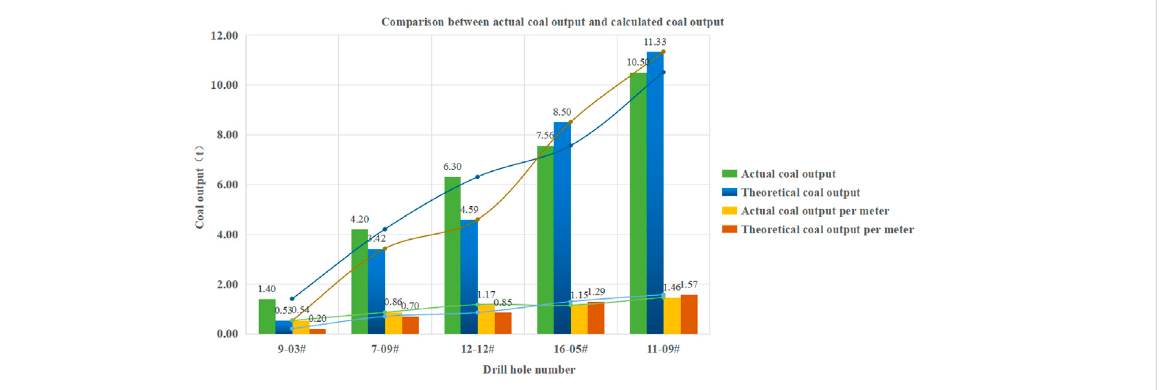
FIGURE 15 Comparison between actual coal output and calculated coal